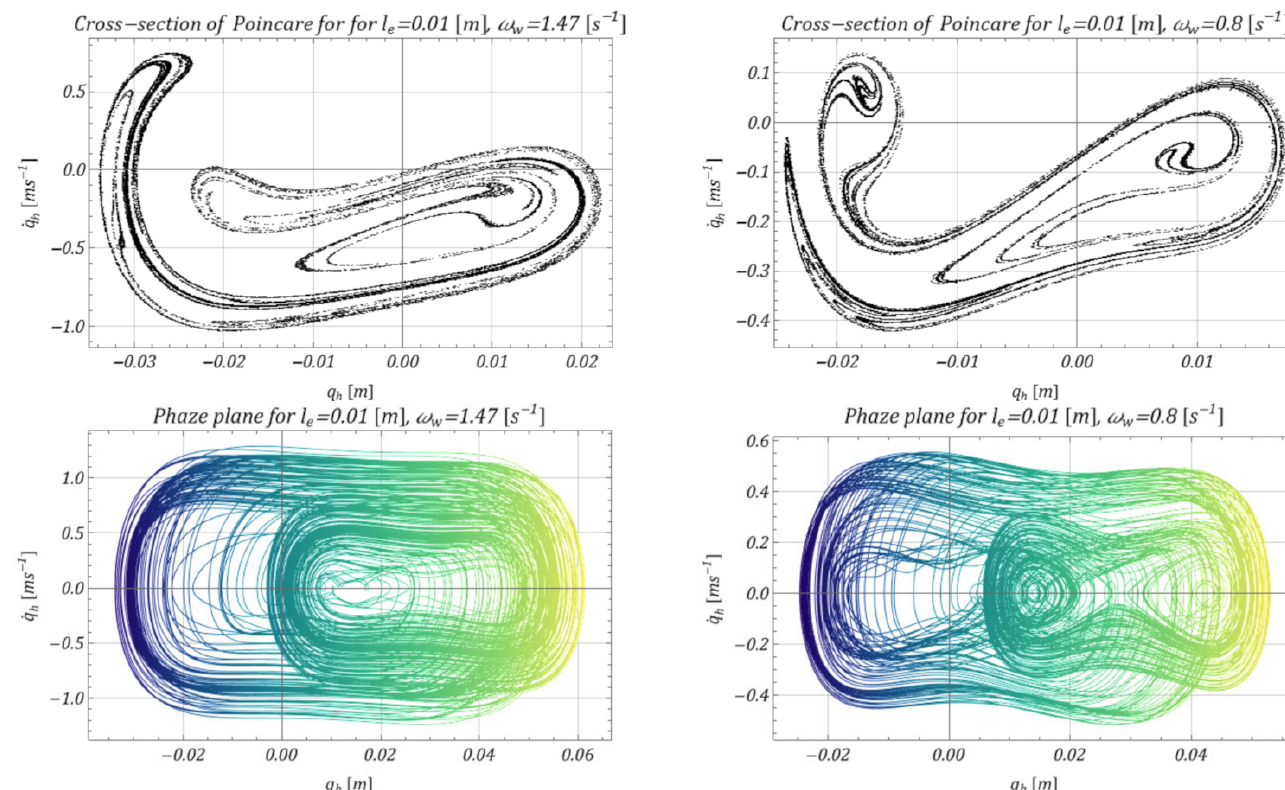
Figure 13. Phase diagrams and Poincar é maps related to selected solutions—sample chaotic solutions for l e = 0.01